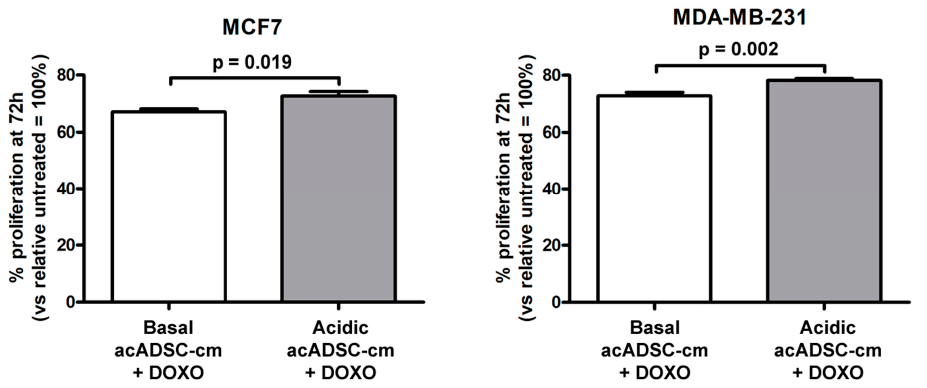
Figure 10 . Proliferation charts of MCF7 and MDA-MB-231 cells treated for 72 h, in the presence or absence of doxorubicin (DOXO), with conditioned media from adipocyte-committed adipose-derived stem cells (acADSCs) grown either under basal (pH 7.4) conditions (basal acADSC-cm) or under lactic acidosis (acidic acADSC-cm). Cell proliferation in the absence of DOXO (i.e., untreated) was set to 100%, and the other results are normalized to this value. Bars represent the mean ± SEM of three independent experiments ( n = 10 replicates each). Values of p were determined by unpaired Student(cid:31)s t -test.